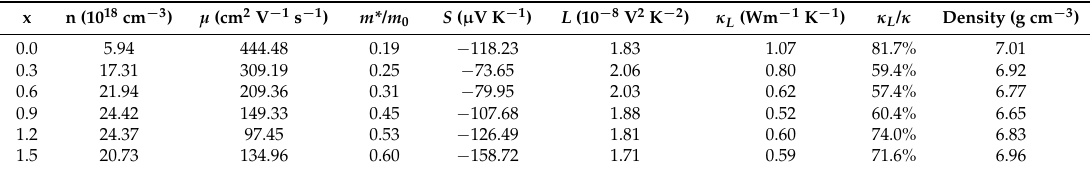
Table 1. Actual composition, carrier concentration (n), carrier mobility ( μ ), carrier effective mass ( m* ), Seebeck coefficient ( S ), Lorenz constant ( L ), lattice thermal conductivity ( κ L ), κ L / κ , and density of Bi 2 Se 3 − x Te x samples at 300 K.